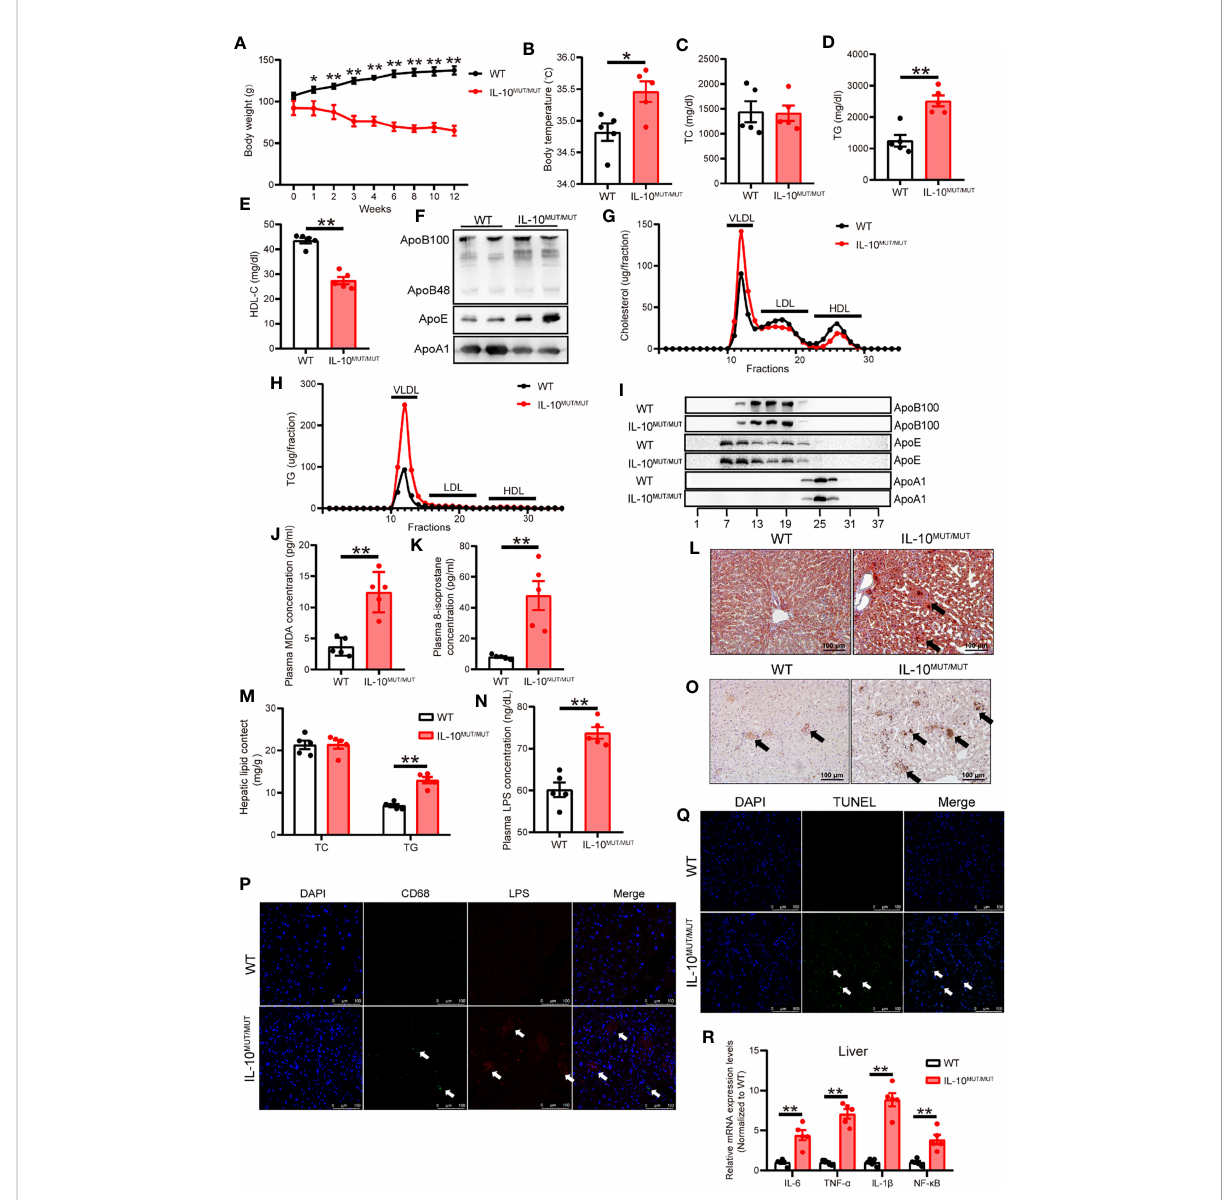
FIGURE 6 Dyslipidemia was aggravated in IL-10 MUT/MUT hamsters on HFD. (A) Body weight curve of WT and IL-10 MUT/MUT hamsters on HFD for 12 weeks (n=5/group). (B) Body temperature of WT and IL-10 MUT/MUT hamsters on HFD (n=5/group). (C, D and E) Plasma TC (C) , TG (D) and HDL-C (E) from WT and IL-10 MUT/MUT hamsters on HFD (n=5/group). (F) Representative Western blots of plasma ApoB, ApoE and ApoA1 from WT and IL- 10 MUT/MUT hamsters on HFD. (G, H) Pooled plasma from the two groups were analyzed by FPLC. Triglyceride (E) and cholesterol (F) contents in different fractions of pooled plasma from WT and IL-10 MUT/MUT hamsters on HFD (n = 6/group). (I) Representative Western blots of ApoB (top), ApoE (middle) and ApoA1 (bottom) in different fractions. (J, K) Plasma MDA (J) and 8-isoprostane (K) concentration from WT and IL-10 MUT/MUT hamsters on HFD (n=5/group). (L) Oil red O stainings of liver tissue of WT and IL-10 MUT/MUT hamsters on HFD. Bars: 50 m m. Arrows indicate lipid accumulation. (M) Hepatic TC and TG contents were measured in HFD-fed animals. (n=6~7/group). (N) Plasma LPS levels from WT and IL- 10 MUT/MUT hamsters on HFD (n=5/group). All values are means ± SEM, **, p<0.01. (O) Immunohistochemistry of CD68 in the liver from WT (left) and IL-10 MUT/MUT (right) hamsters on HFD. Bars: 50 m m; arrows indicate positive stainings. (P) Cryo-sections of liver from WT (top) and IL- 10 MUT/MUT (bottom) hamsters on HFD were double-stained with CD68 (green) and LPS (red) antibodies. Nuclei were stained with DAPI (blue). Bars: 100 m m; white arrows indicate positive stainings. (Q) TUNEL staining (green) in the iWAT from WT (top) and IL-10 MUT/MUT (bottom) hamsters on HFD. Nuclei were stained with DAPI (blue). Bars: 100 m m; white arrows indicate positive stainings. (R) Expression levels of in fl ammatory factors in liver were determined by real-time PCR (n=5/group). All values are means ± SEM, **p<0.01. All date were expressed as means ± SEM, *p<0.05;